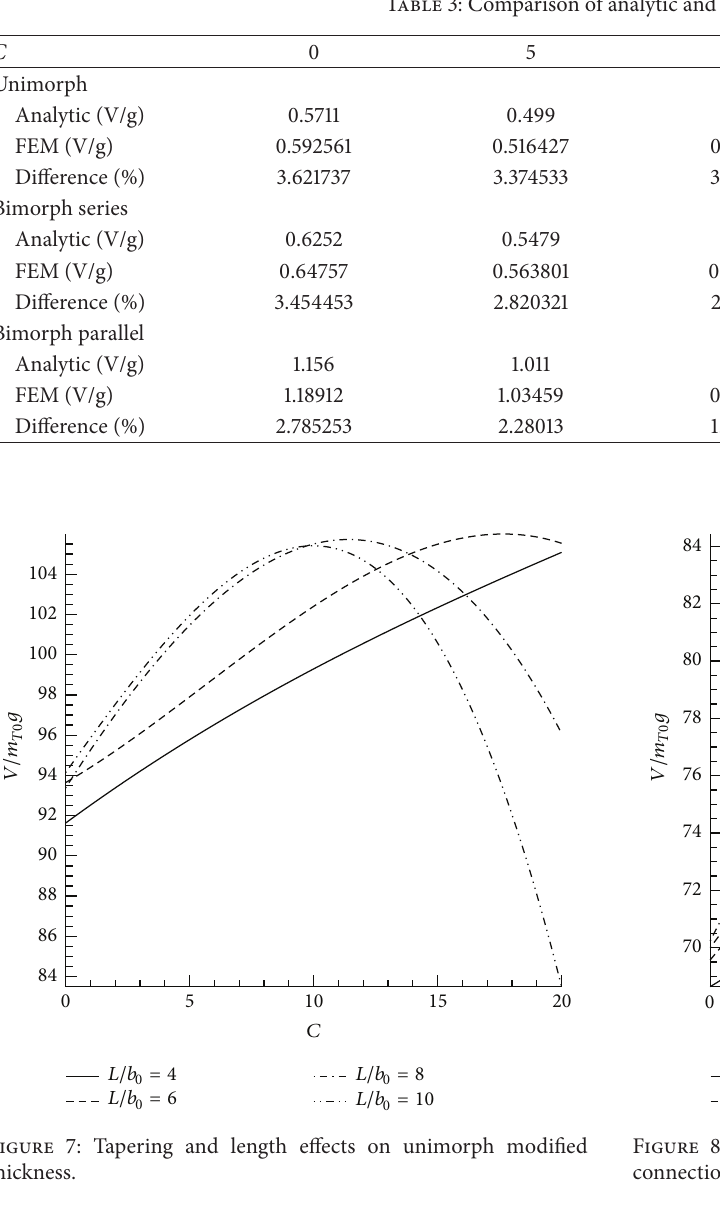
Figure 6: Geometry of the beam with different tapering parameter values. Table 3: Comparison of analytic and FEM results.